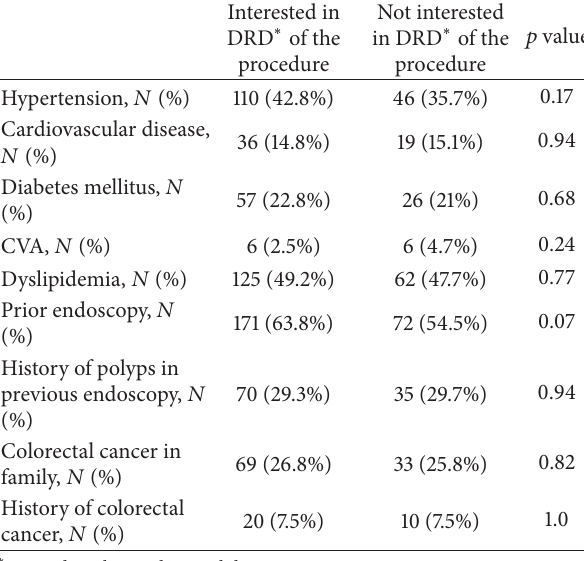
Table 1: Patients’ population: demographic data. Table 2: Patients’ medical history.